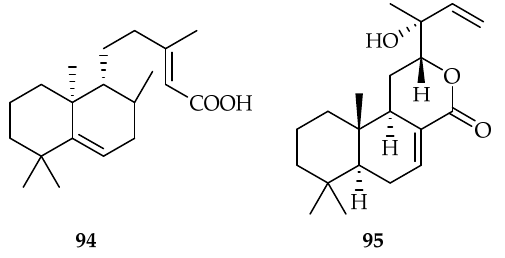
Figure 38. Structure of compound 94 [58] and sublyratin I 95 [59].